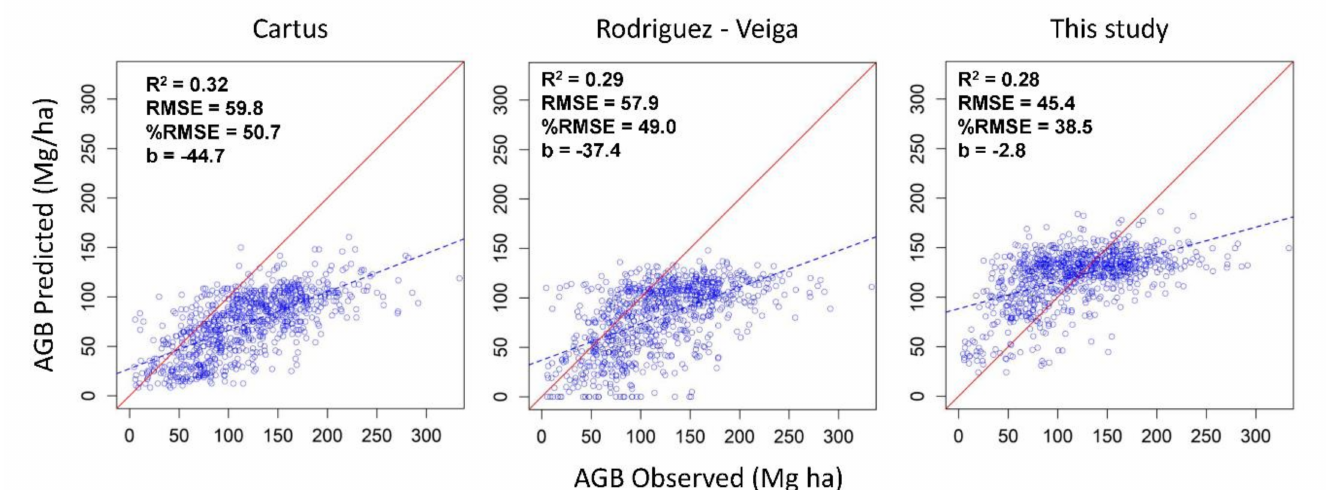
Figure 6. Observed versus predicted values for aboveground biomass in the maps generated in this study compared to the maps of Cartus el at. [14] and Rodriguez-Veiga et al. [15] for the Yucatan Peninsula. Red lines are reference lines 1:1, while dashed lines are regression lines.